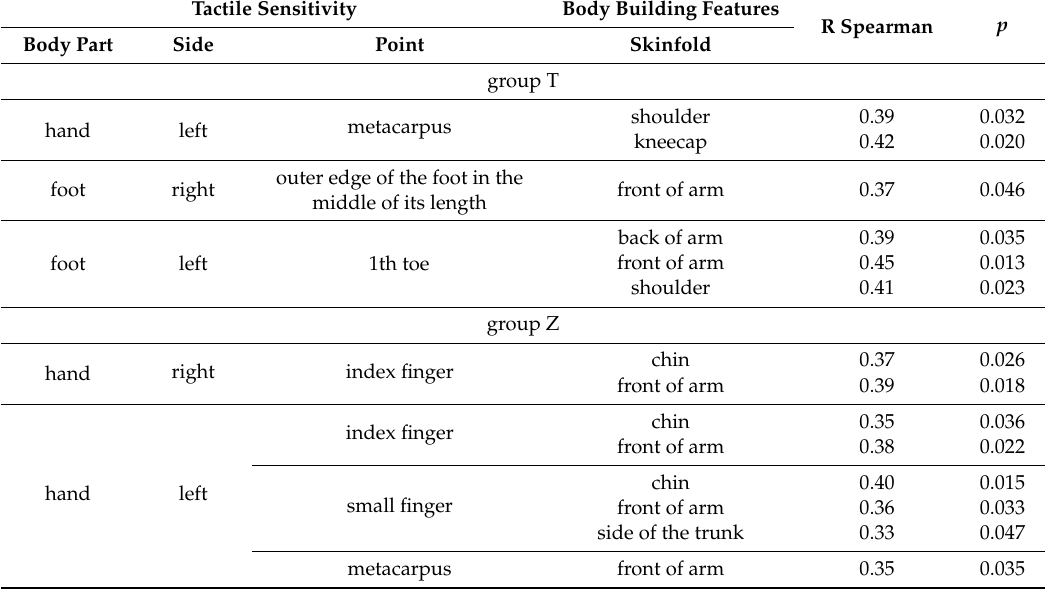
Table 3. Statistically significant correlations of the tactile sensitivity threshold on hands / feet and the thickness of skinfolds in the group of Turner syndrome women (group T) and healthy volunteers (group